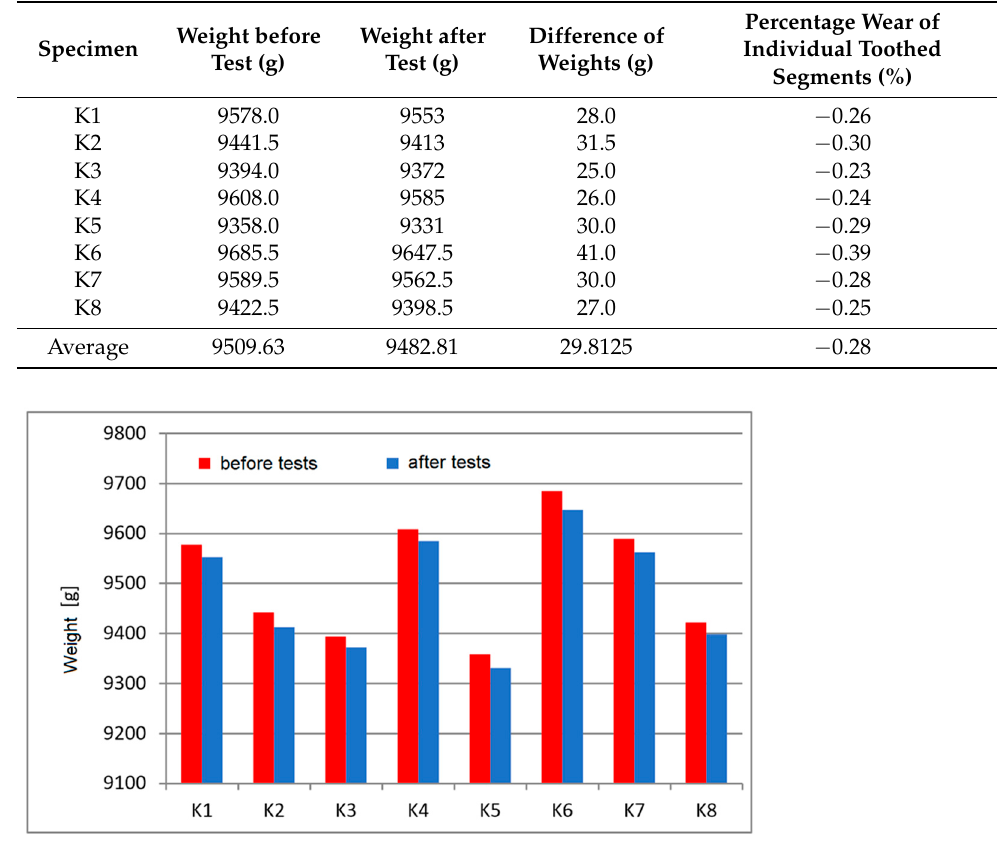
Figure 14. Weight value of individual specimens of toothed segments before and after functional tests.